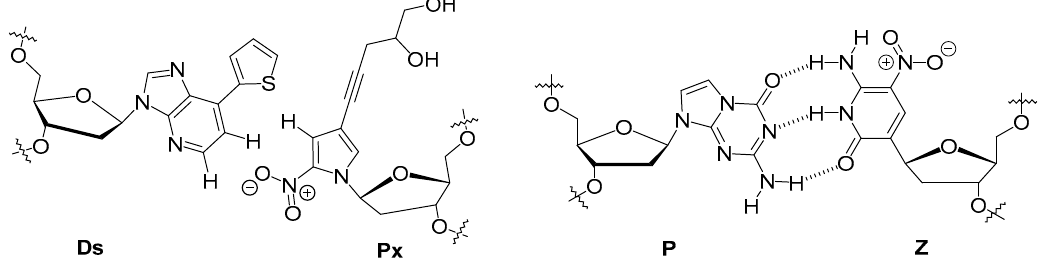
Figure 8. Chemical structures of the unnatural base pairs Ds Px and dP dZ used in the expansion of the genetic code.